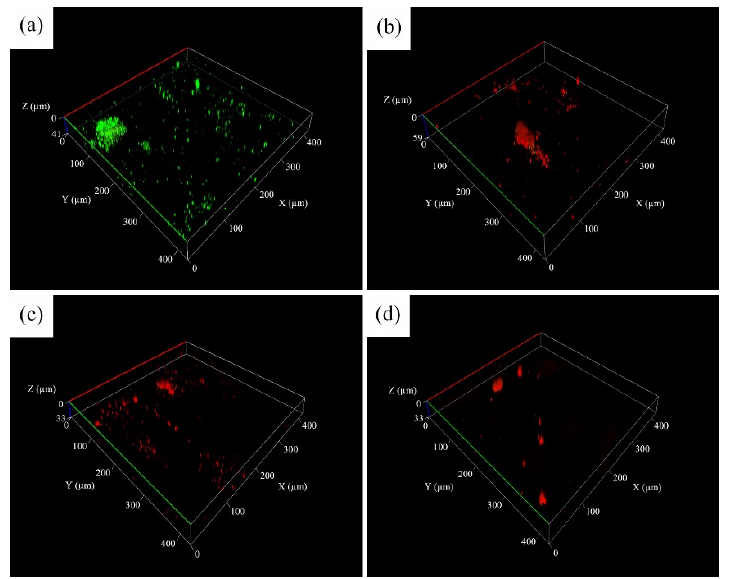
Figure 12. CLSM images of Zuoying inocula incubated for 336 h with varying concentrations of composite biocides under ( a ) no treatment, ( b ) TB, ( c ) 3TB, and ( d ) 5TB.